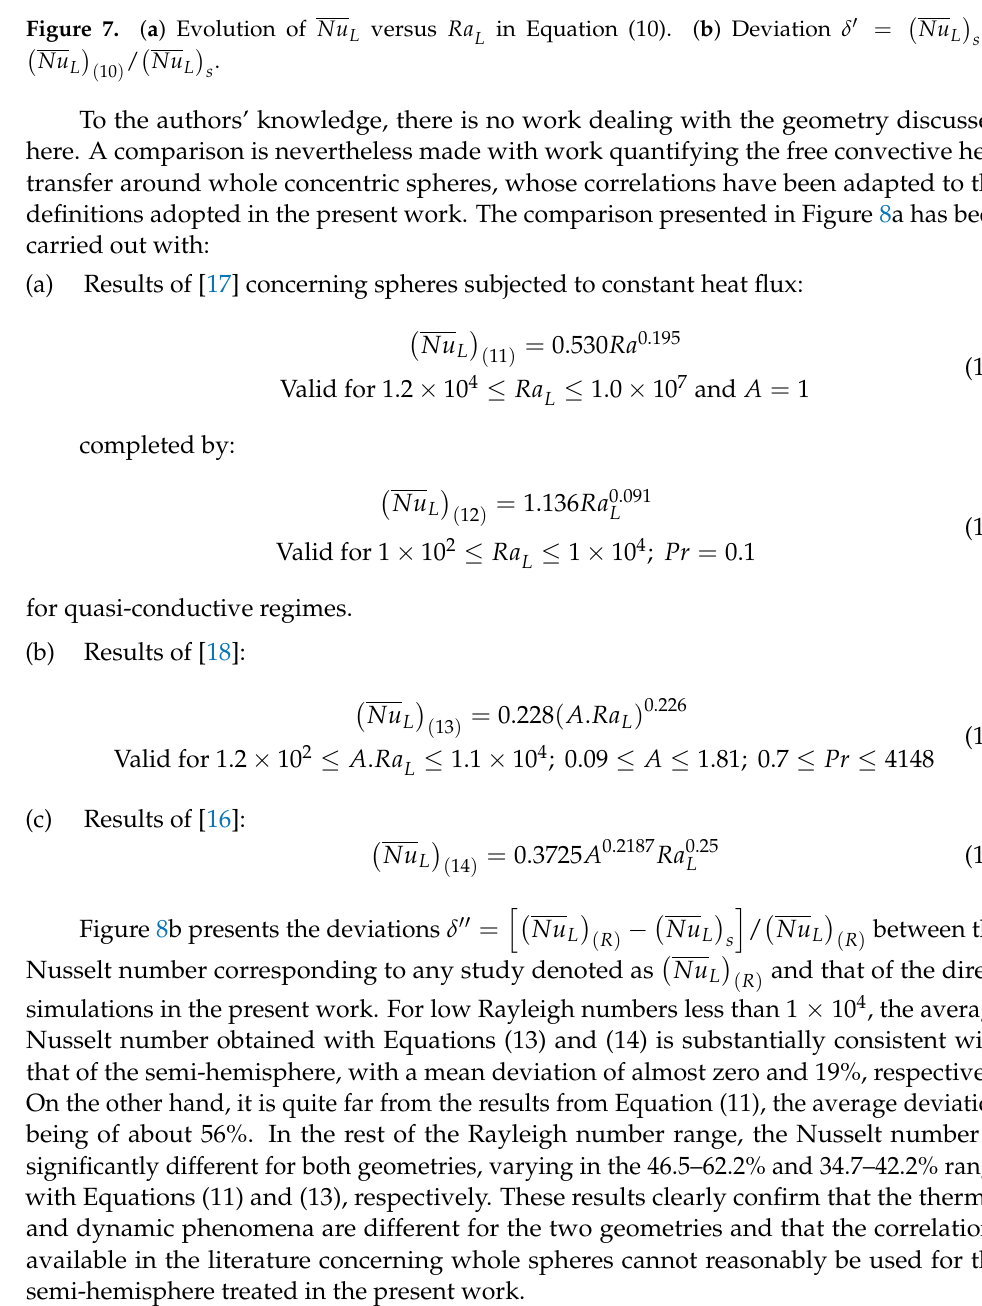
in Equation (10). ( b ) Deviation δ (cid:48) = L